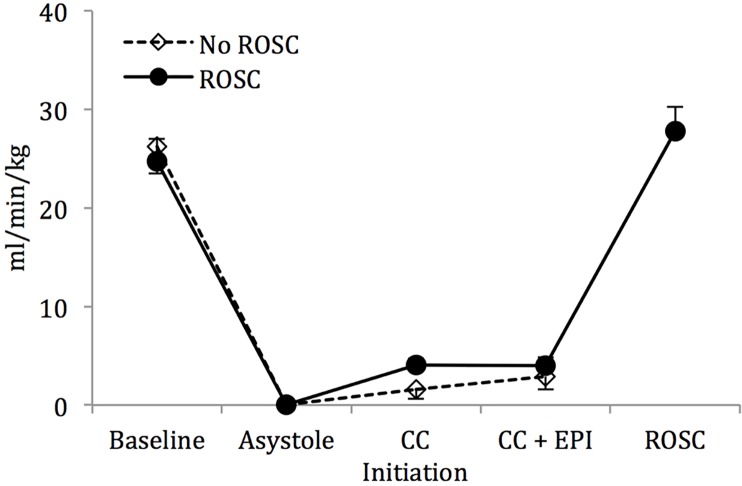
Mean left carotid artery flow.There is only a modest increase in flow following initiation of chest compressions with no further increase after epinephrine use. Data are mean ± SEM bars.